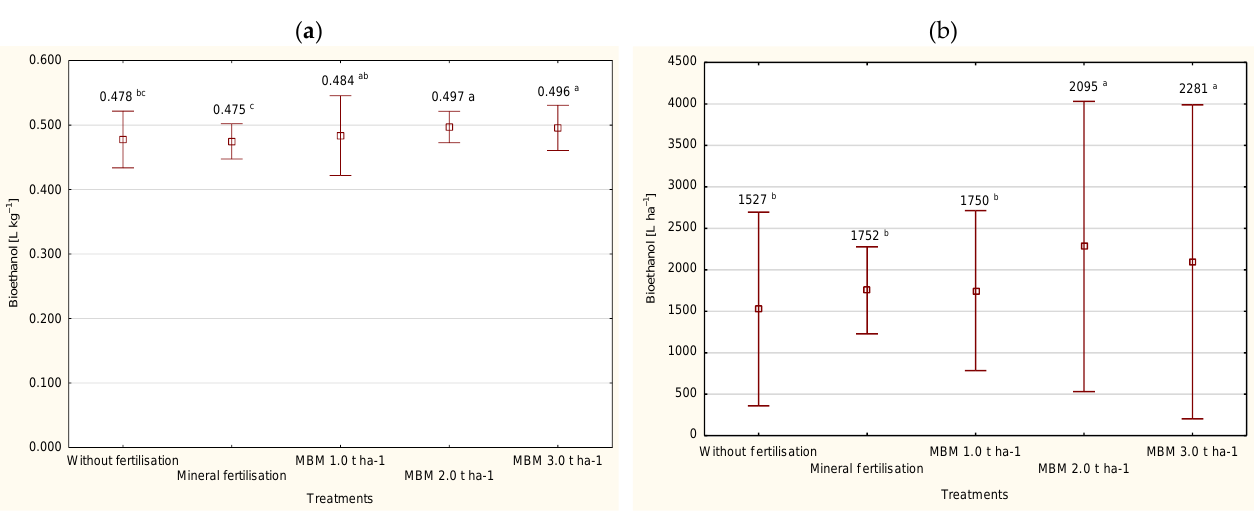
Figure 5. Volume of bioethanol (mean value and standard deviation) obtained from corn grain ( a ), and bioethanol yield from a hectare ( b ), considering year of experiment. MBM – Meat and Bone Meal. a,b,c — Values followed by the same letters do not differ significantly in Tukey’s (HSD) test ( p < 0.05).